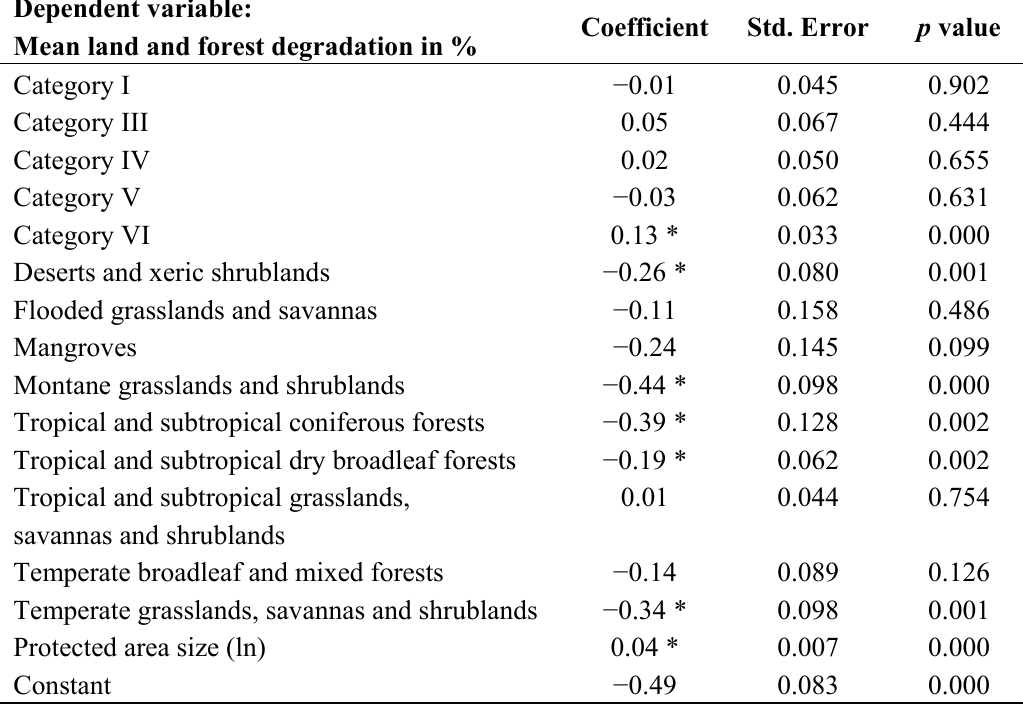
Table 6. Regression results for major habitat type, management category, and